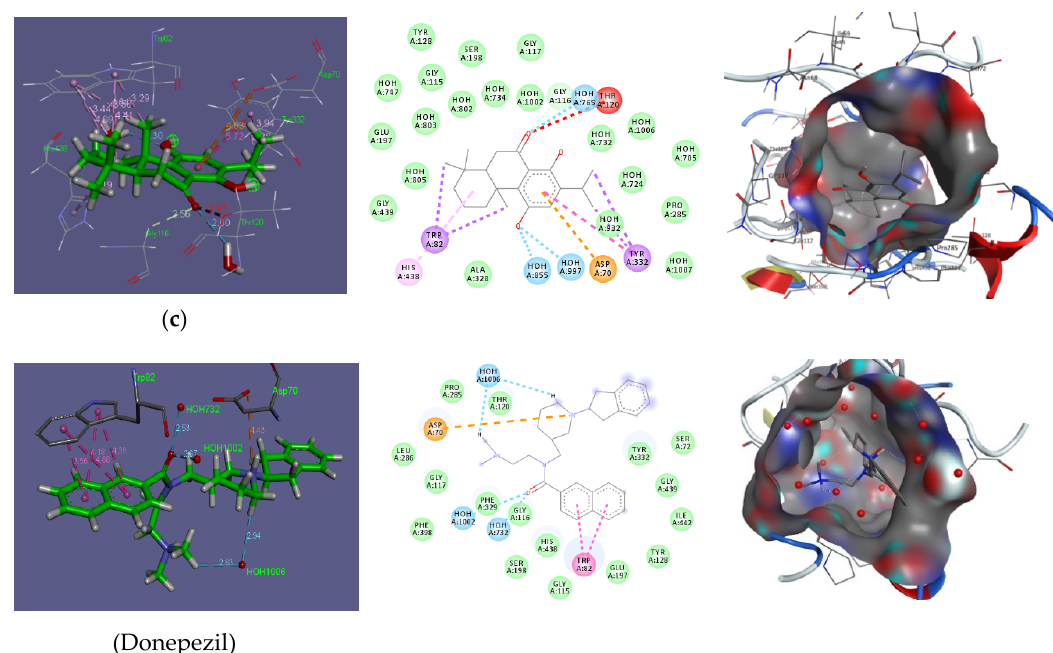
Figure 3. Docking of compounds 1 ( a ) , 2 ( b ) , and 3 ( c ) in Acetylcholine esterase enzyme in comparison to donepezil as a reference drug.